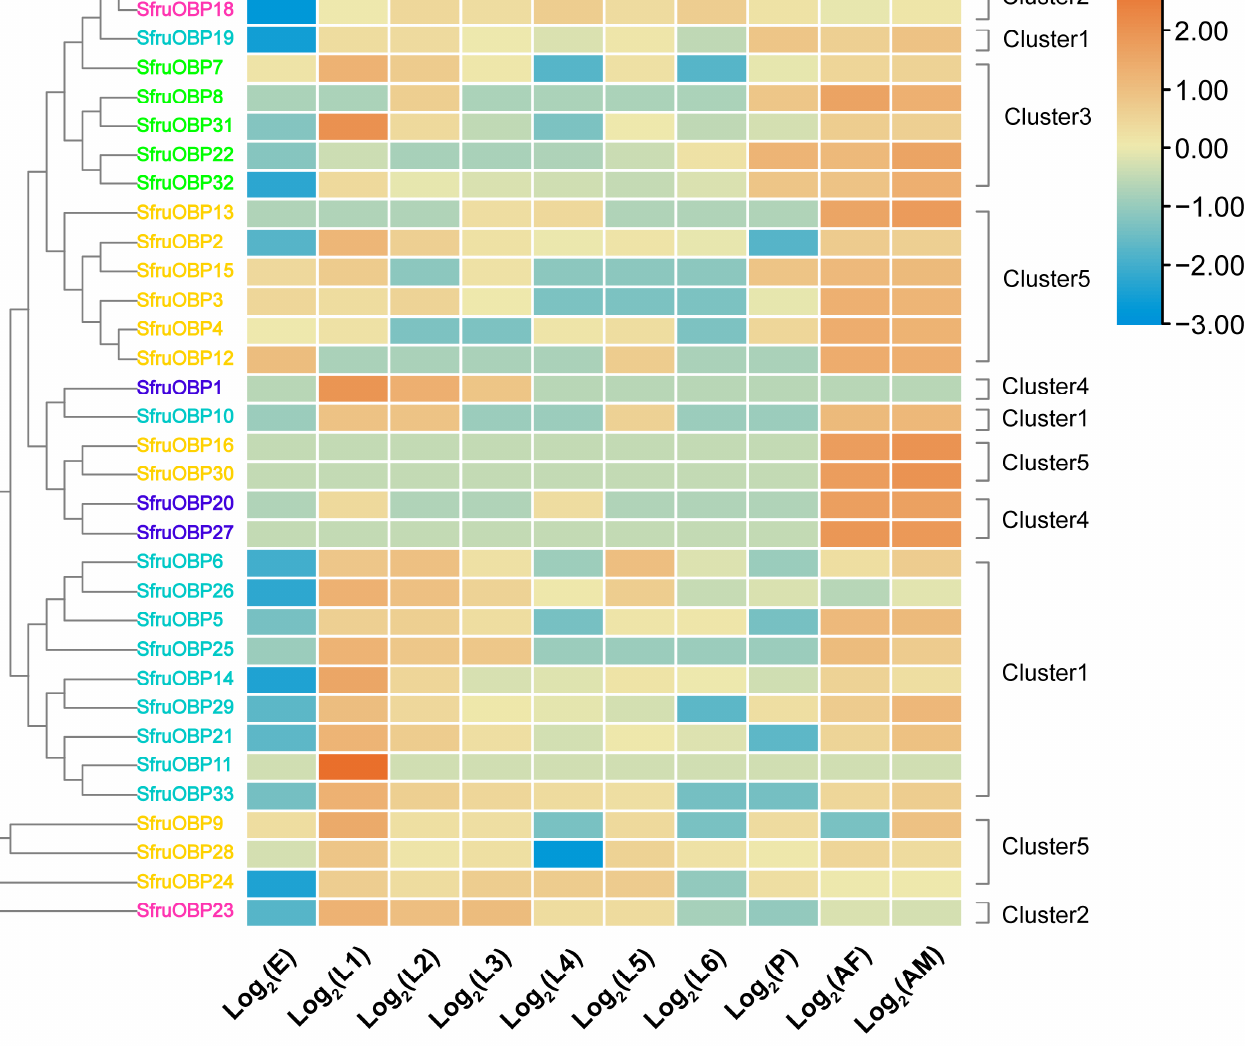
Figure 9. Expression heat map of SfruOBPs in eight developmental stages and across adult sexes (E: eggs; L: larvae; P: pupae; A: adult, where F: females and M: males). Expression values are scaled by row. The level of expression is indicated by different colors (right). Yellow represents positive expression, and the darker the color, the higher the expression level; blue represents negative expression, and the darker the color, the lower the expression level. For each sample we used three replicates. Different colors on gene names indicate OBPs from specific Clusters as indicated in Figure 1: cyan, Cluster 1; pink, Cluster 2; bright green, Cluster 3; blue, Cluster 4; orange, Cluster 5.